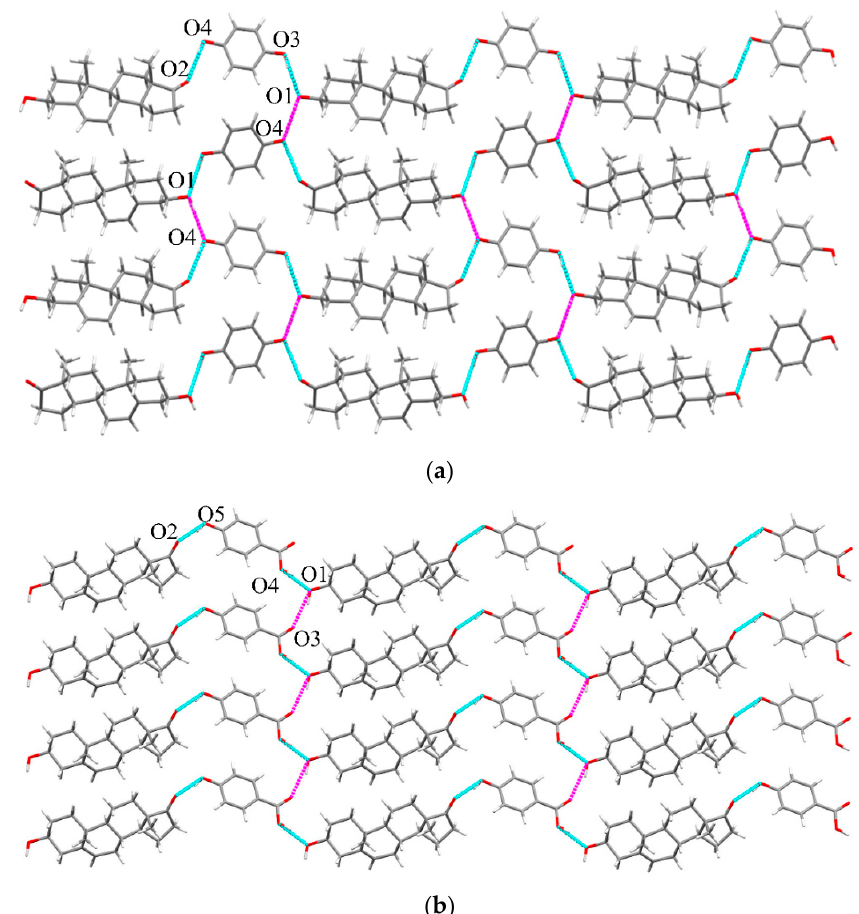
Figure 4. 2D architecture of ( a ) DHEA-HQ and ( b ) DHEA-PHBA. DHEA-RES cocrystal (2:1). The DHEA-RES takes the orthorhombic P 2 1 2 1 2 1 space group with Z = 4. The ASU of DHEA-RES contains two DHEA molecules and one RES molecule. A supramolecular three-fold helix is formed via continuous O5-H5···O1 (2.671 Å), O1-H1···O3 (2.859 Å) and O3-H3A···O5 (2.858 Å) interactions as shown in Figure 5a,b. These helixes are then connected through O4···H6A-O6 (2.798 Å) to construct the 2D hy- drogen-bonding structure in Figure 5c.